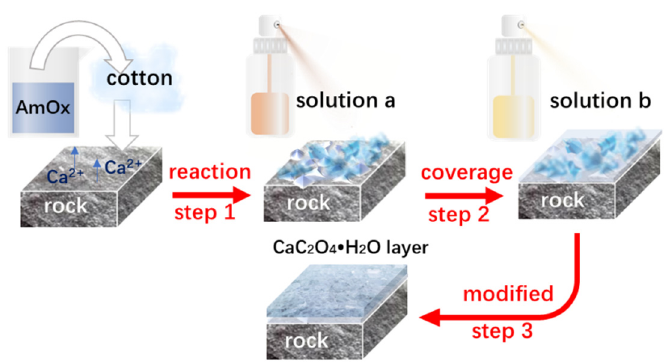
Figure 1. Scheme illustrating the treatment process of each